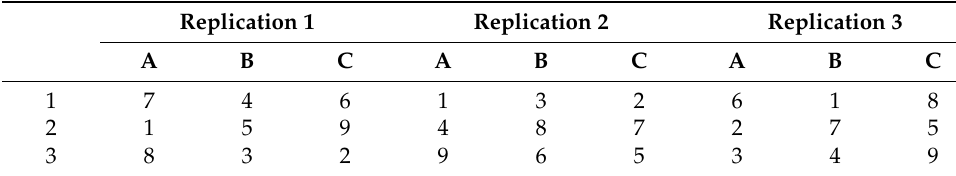
Figure 6. Placement of specimens during printing. Table 6. Randomizationed position of